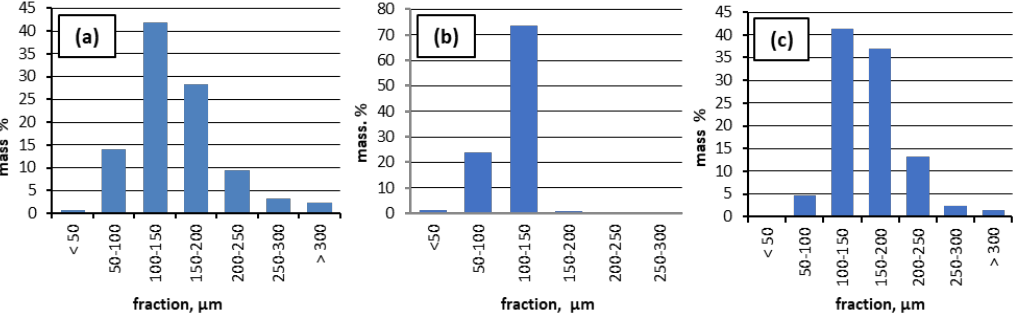
Figure 2. Particle size distribution (PSD) of the three types of cenospheres: ( a ) CS1, ( b ) CS2, and ( c ) CS3.